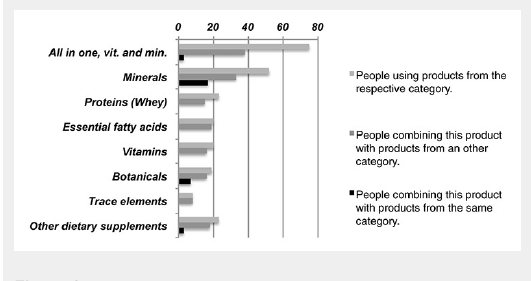
Categories and combinations of dietary supplements used (n = 147).